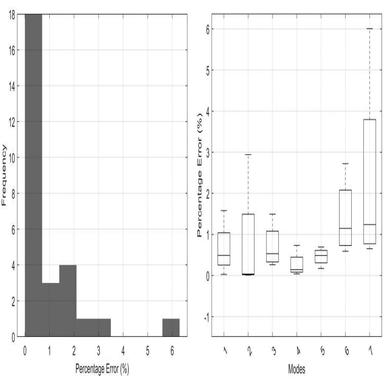
YUKI-Gradient Boosting frequency prediction errors.